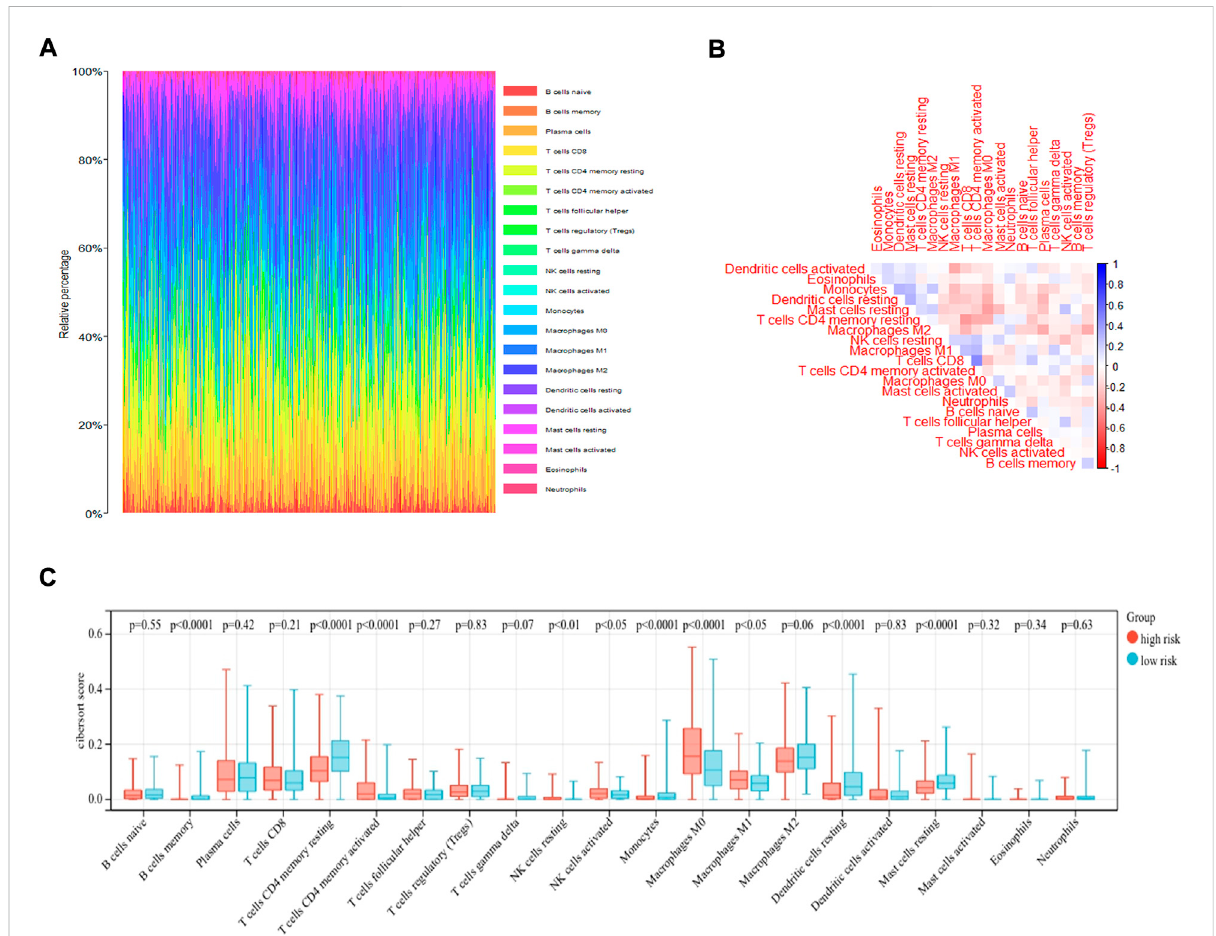
FIGURE 6 CIBERSORTanalysisofTCGA-LUADdataset. (A) Thebarplotdisplayedtheratioofdifferentimmunein fi ltratingcellsintheTCGA-LUADdatasets based on CIBERSORT algorithm. (B) The correlation of immune in fi ltrating cells. (C) Different kinds of immune in fi ltrating cells are plotted according to risk score